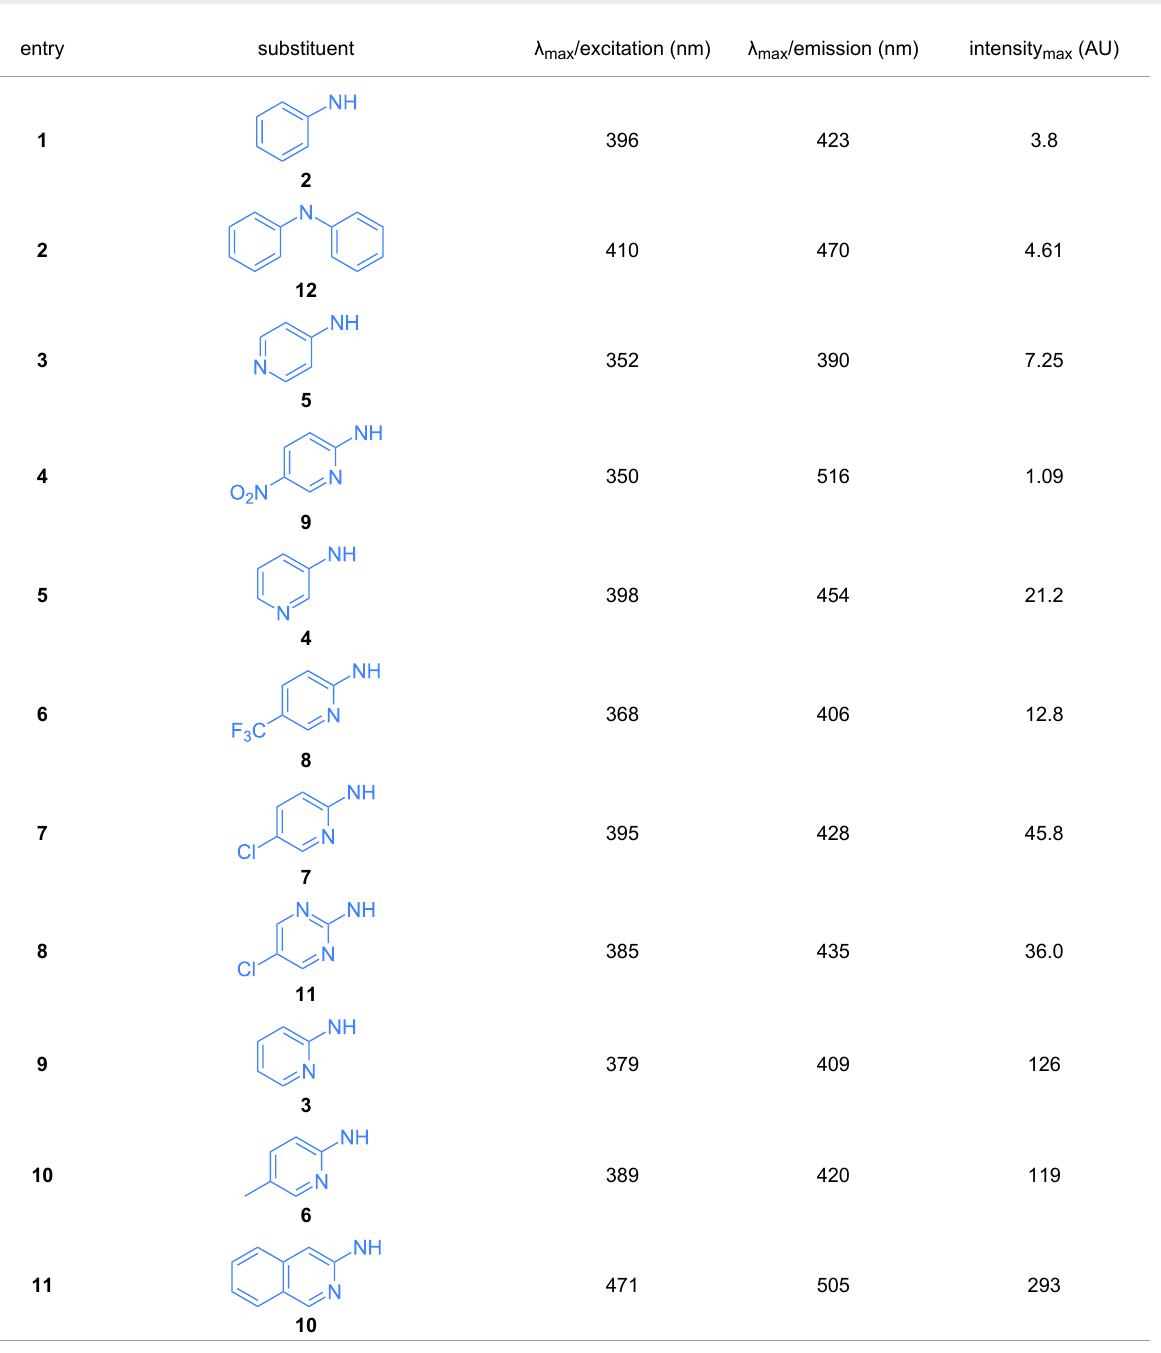
Table 1: Fluorescence measurement data.